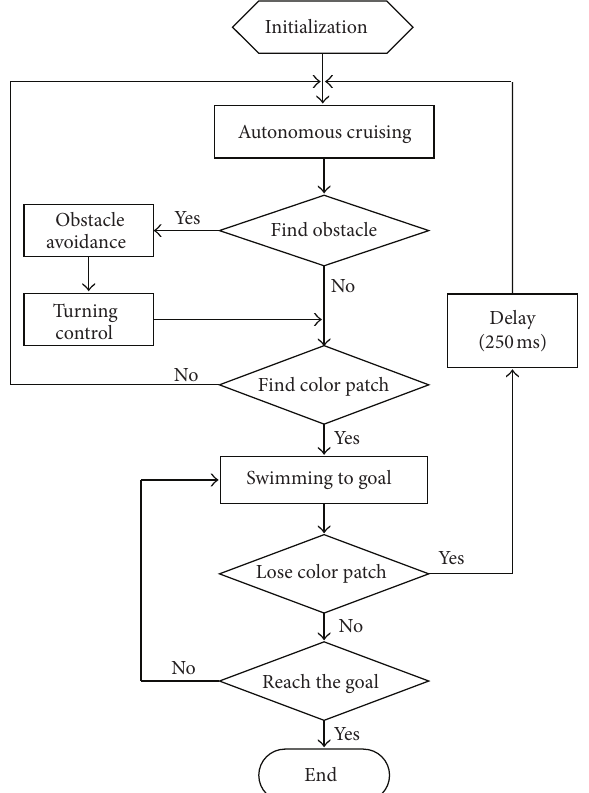
Figure 6: Flowchart of embedded vision-based navigation strategy.